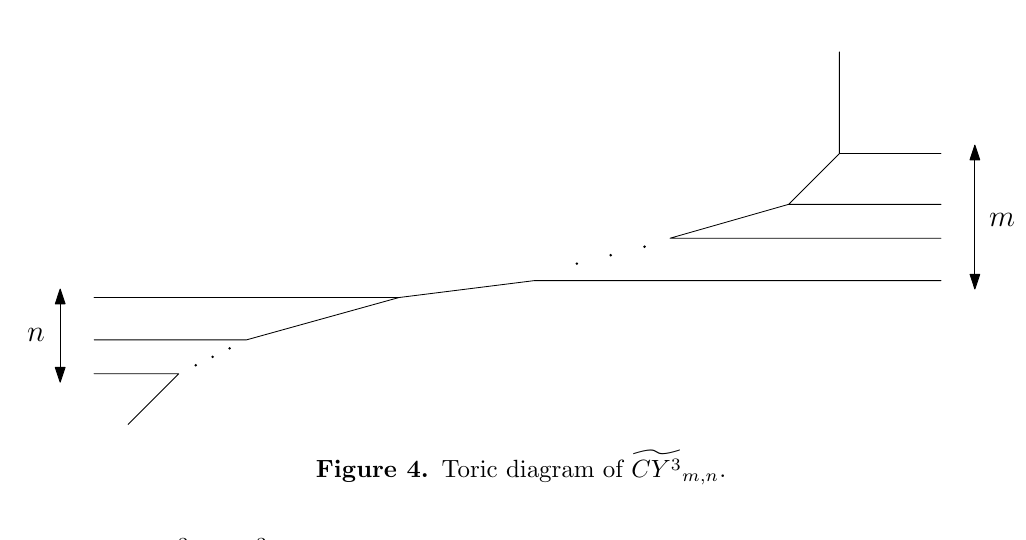
Figure 4. Toric diagram of